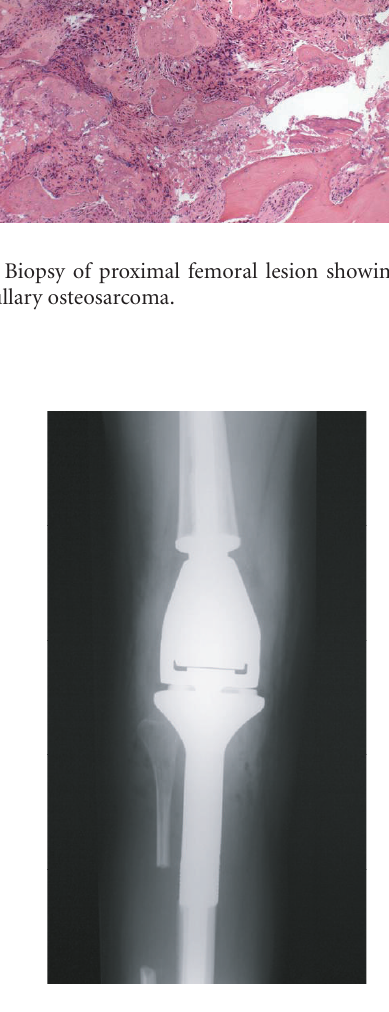
Figure 4: Postoperative x -rays showing prosthetic